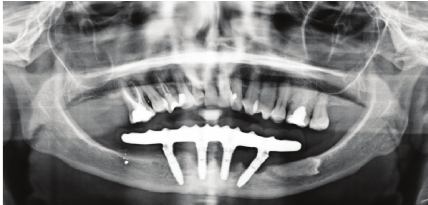
Figure 6: Orthopantomography of the patient after 84 months from surgery.